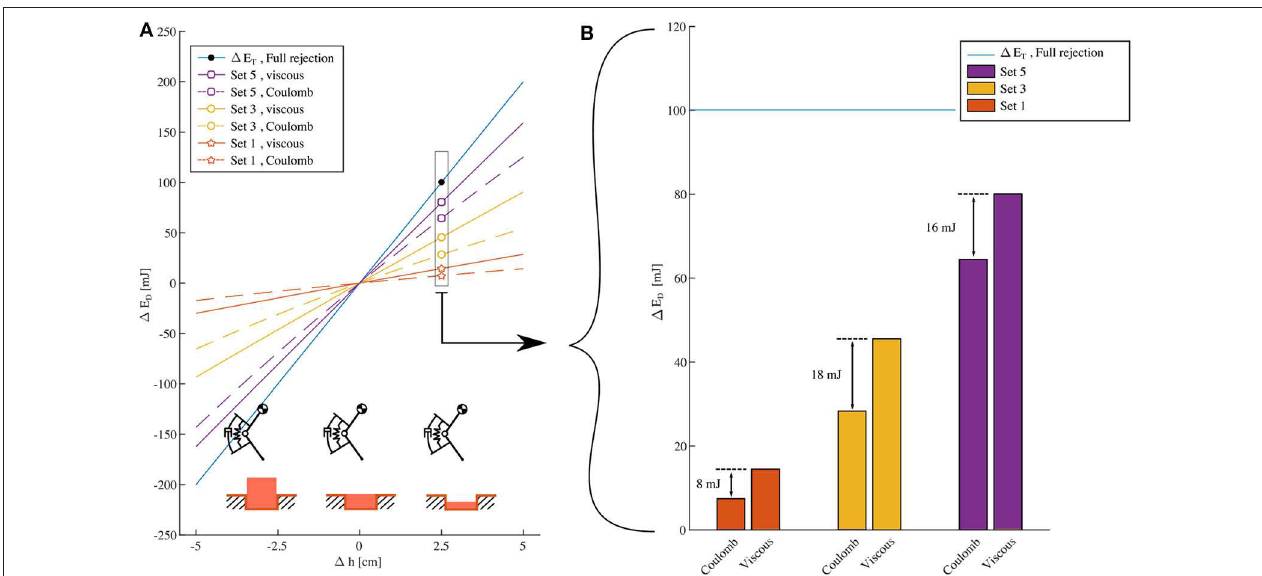
FIGURE 4 | Numerical simulation Cases 1 and 2 from Figure 2 , (A) : Change of dissipated energy vs. change of drop height for set 1, 3 and 5, with damping coefficients as in Table 2 . Continuous lines are viscous damping results, dashed Coulomb damping. Positive perturbations, i.e., 1 h > 0, correspond to step-down perturbations; step-up perturbations, otherwise. The steepest line indicates the slope needed for a full rejection of a 1 h deviation. For each set (1, 3, 5), the damping parameters are matched such that viscous and Coulomb damping dissipate the same energy at the reference height h 0 (see Table 2 ). Within each set, the viscous damping line is closer to the desired full rejection line than the corresponding Coulomb damping line. This means that for the same cost (in the sense of dissipated energy at the reference height) viscous damping always rejects more of ground level perturbation than Coulomb damping. (B) : 1 E D for 1 h = 2.5cm. The horizontal line indicates the amount of energy to dissipate for full rejection of 1 h . Energetic advantage of viscous damping over Coulomb damping, as indicated by the spread in the corresponding 1 E D values, increases from set 1 to 3, and reduces from set 3 to 5.